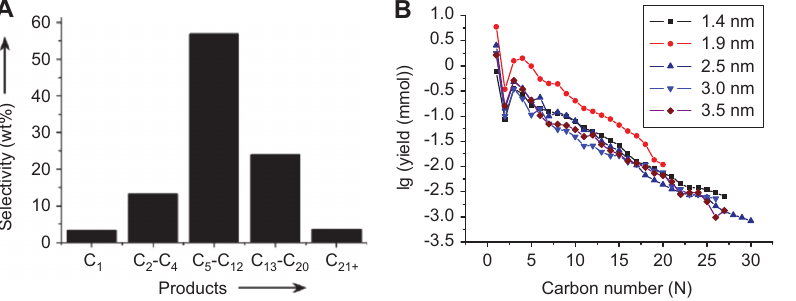
Figure 8 (A) Hydrocarbon selectivities for 2.0-nm-diameter nanoclusters; (B) ASF distribution of products for Ru nanocluster catalysts with different diameters. Reaction conditions: 150 ° C, 2.0 MPa H , 1.0 MPa CO, 2.79 × 10 -4 mol Ru, 20 ml water (Adapted from ref [21]. Copyright 2 (2008), with permission from John Wiley and